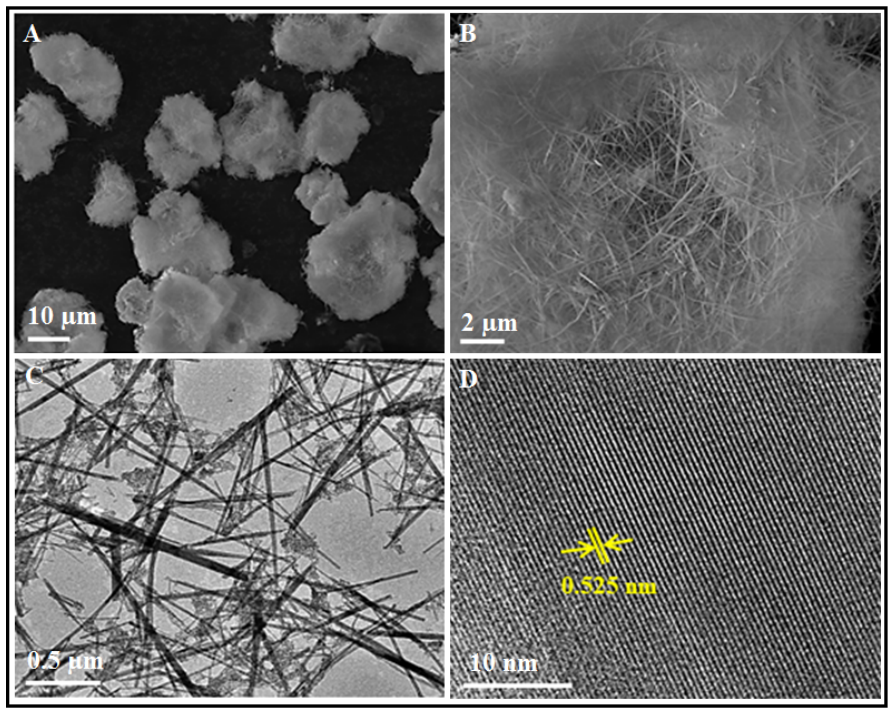
Figure 7. ( A , B ) SEM images and ( C , D ) TEM and crystal lattice of the 1D-assembly of CoTi-LDH IR-responsive for OER.